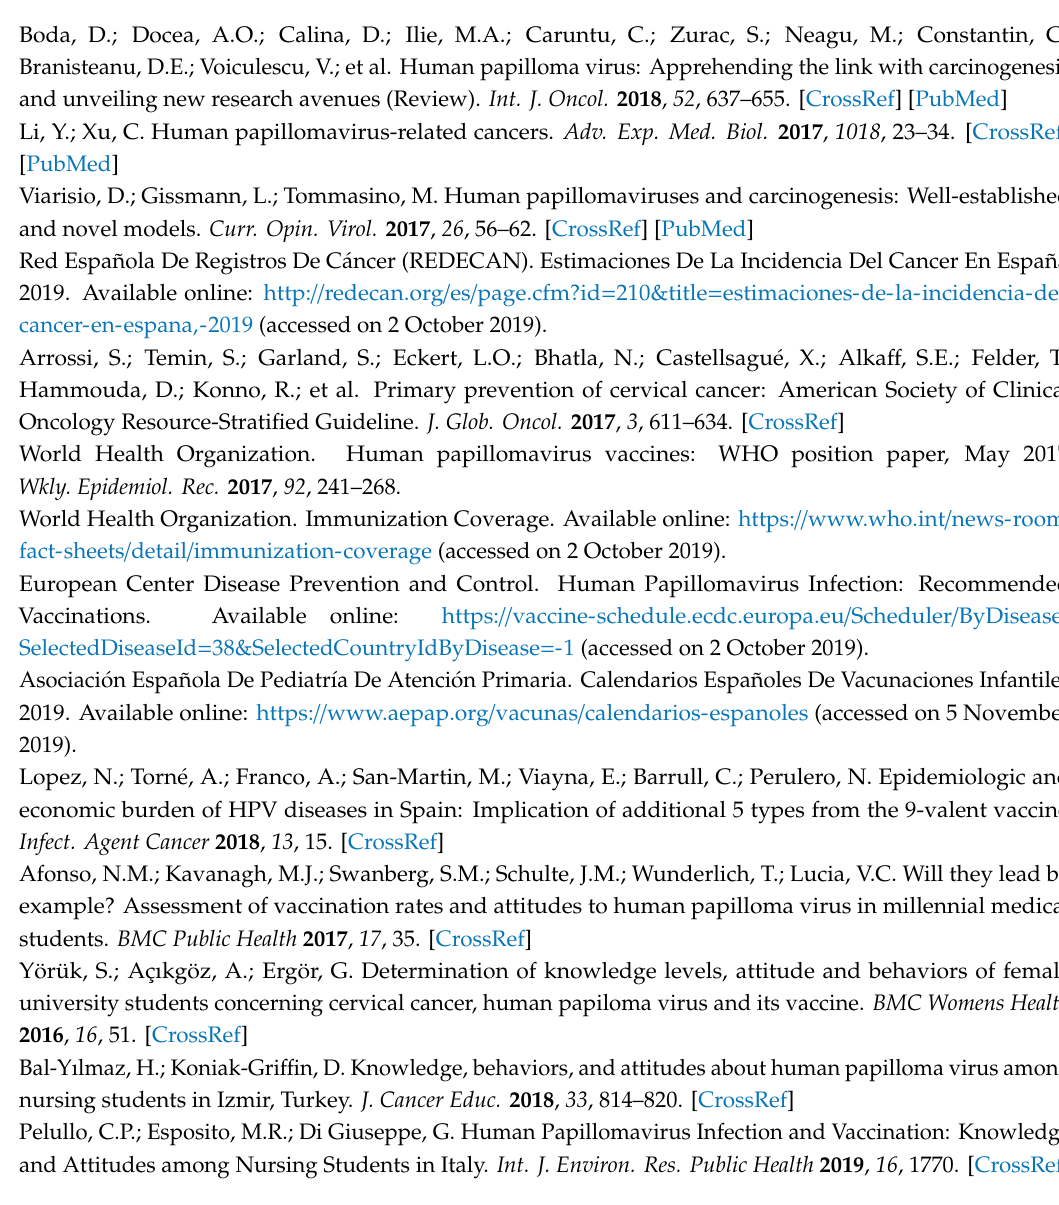
Table S1 Spanish version of the questionnaire “Knowledge, attitudes and intentions towards human papilloma virus (HPV) vaccine”. Adapted from Dany et al.